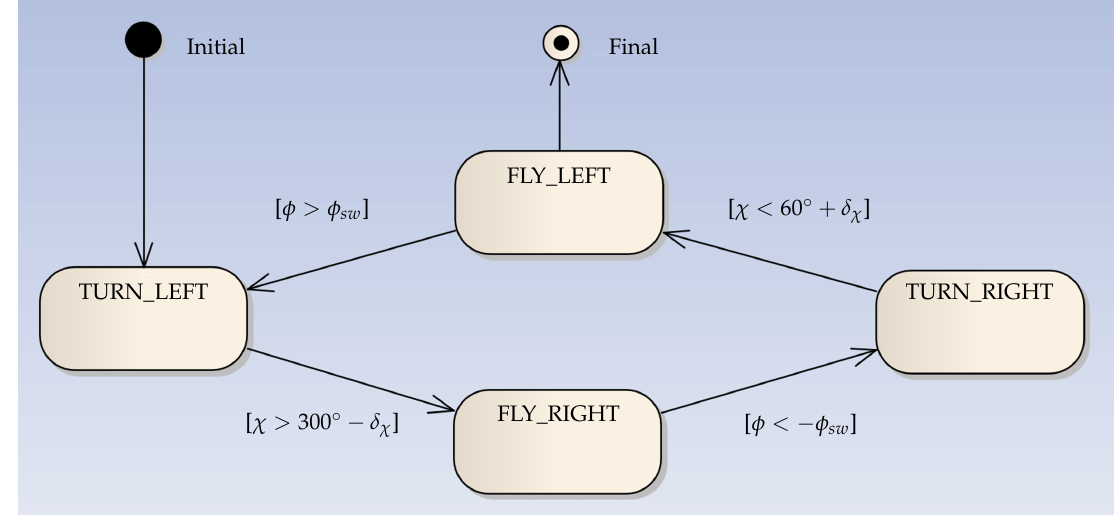
Figure 6. Finite substate diagram showing the substate and the transitional condition of the figure-of-eight